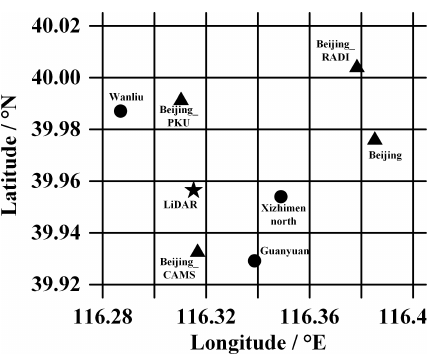
Figure 1. Geographic coordinates of the ground-based lidar site (star), air quality monitoring sites (circles) and AERONET sites (tri- angles).